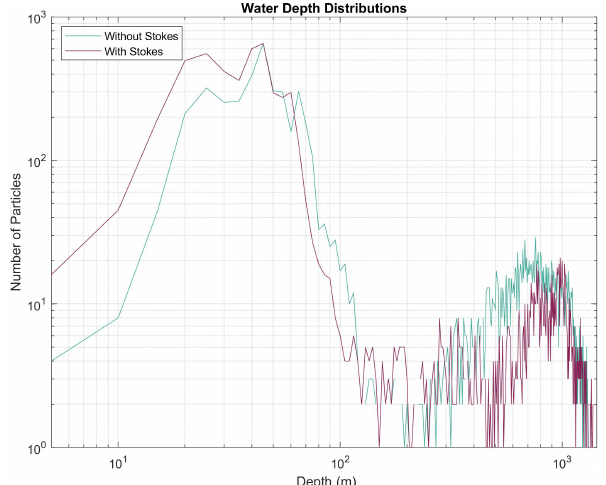
Figure 8. Total water depth at particle locations for cases with- out Stokes drift (J) and with Stokes drift (K). The histograms show depths after 30d of simulation. More particles ended in water depths less than 50m when Stokes drift was included (57%) than when it was omitted